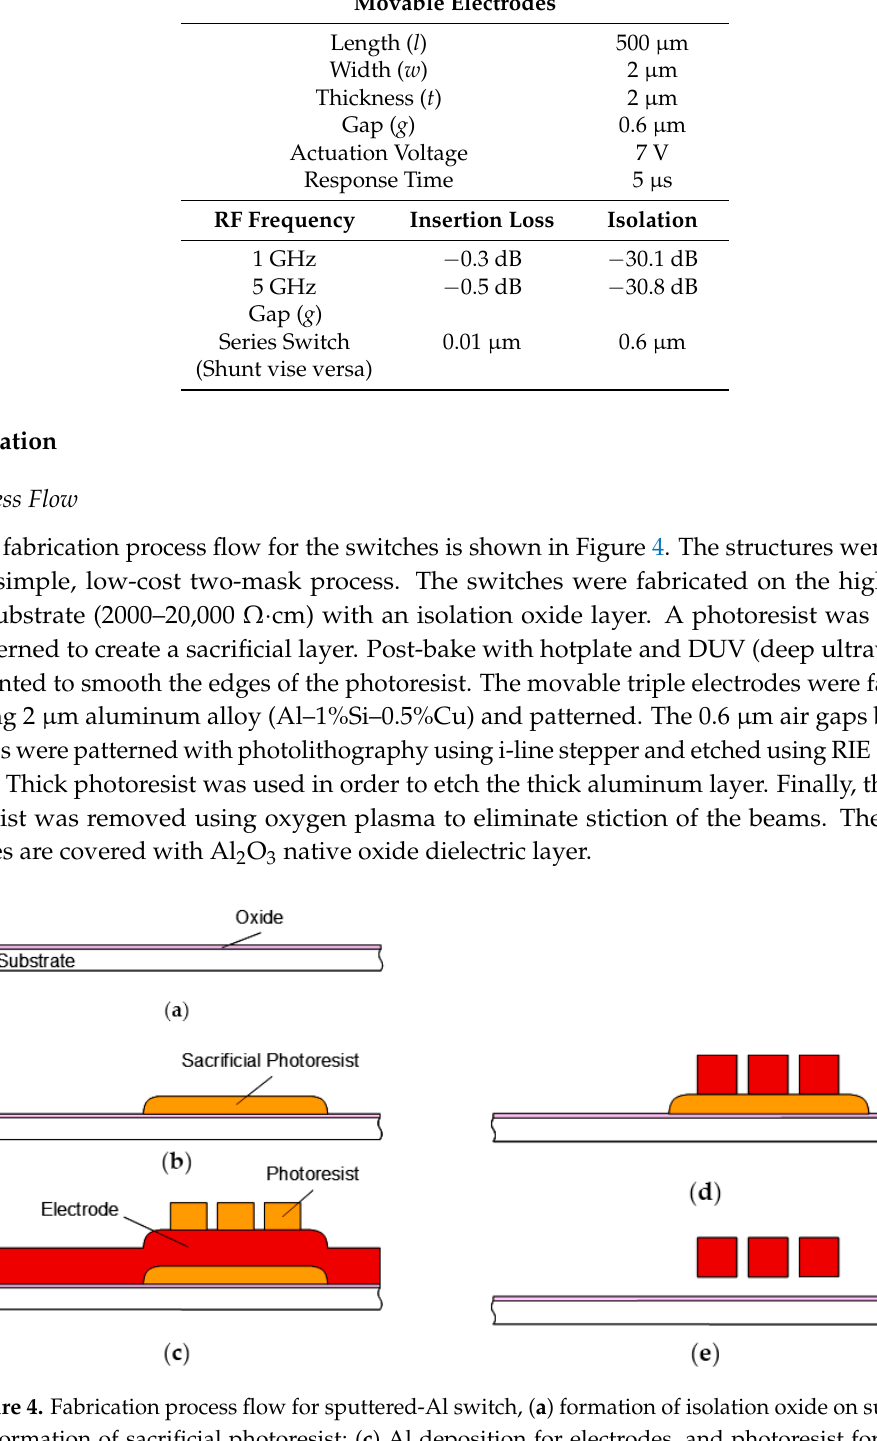
Table 1. Designed Specifications of Movable Triple Electrodes Actuator in radio frequency micro-electro-mechanical systems (RF-MEMS) switches.